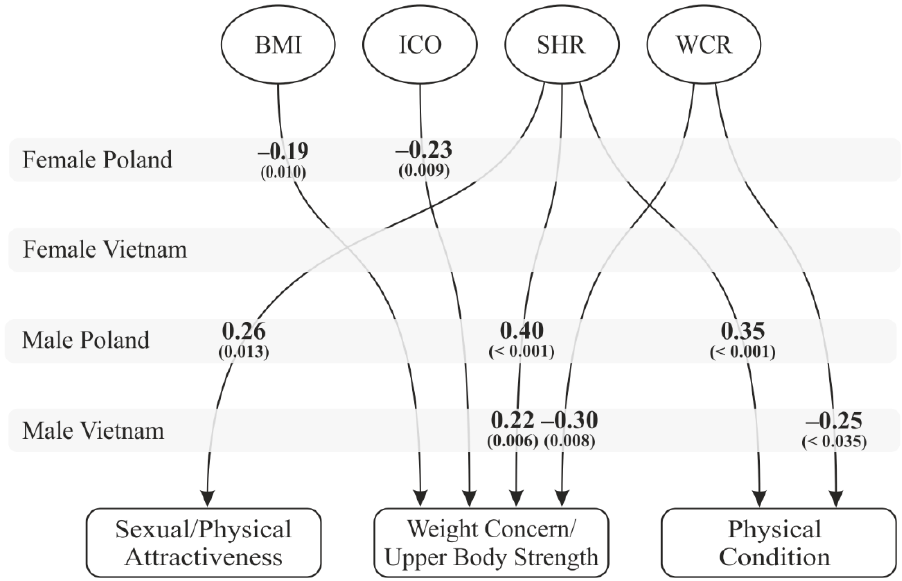
Figure 2. Anthropometric indicators as predictors of body esteem.